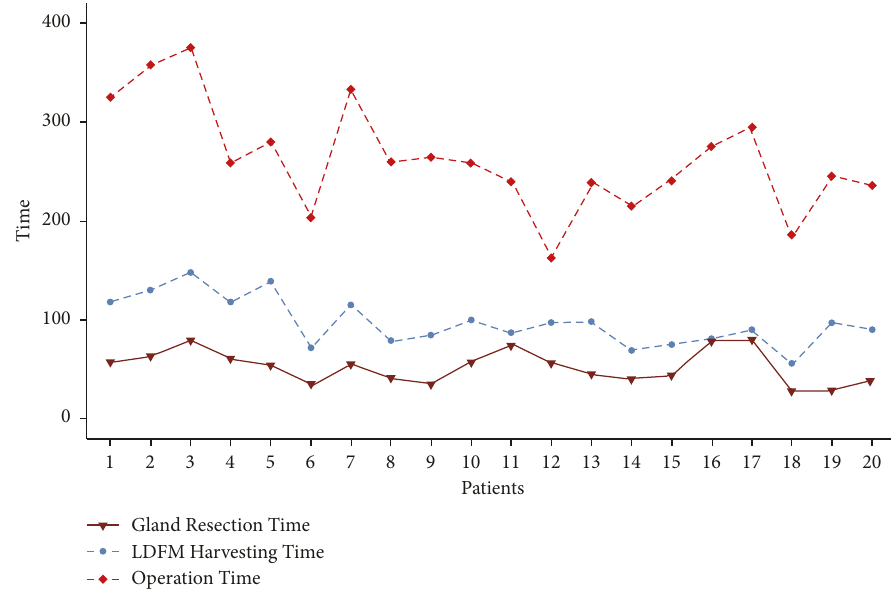
Figure 3: The changing trend of the operation-related time of the 20 patients. Table 2: Operative and perioperative